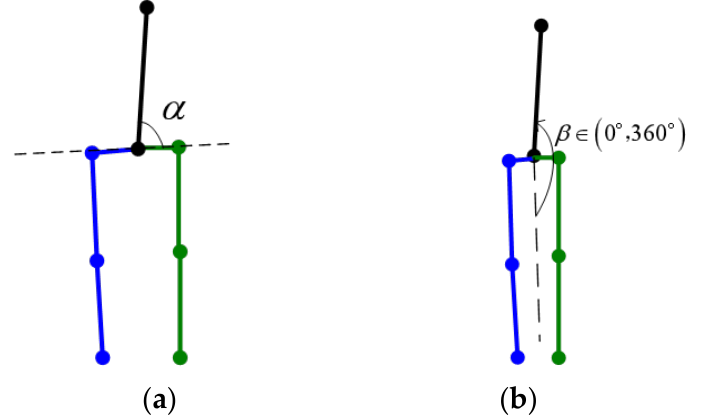
Figure 6. The angles of the spine. ( a ) α for rule (1); ( b ) β for rule (2). b β is the confidence function for rule (2), where β ∈ ( 0 ◦ , 360 ◦ ) is shown in Figure 6b, when the angle between the spine and the dashed line is less than 30 ◦ , or more than 210 ◦ , the confidence will decline